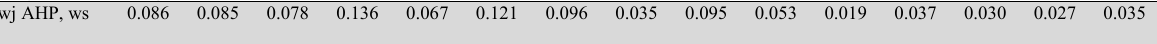
Subjective weights wj AHP, ws